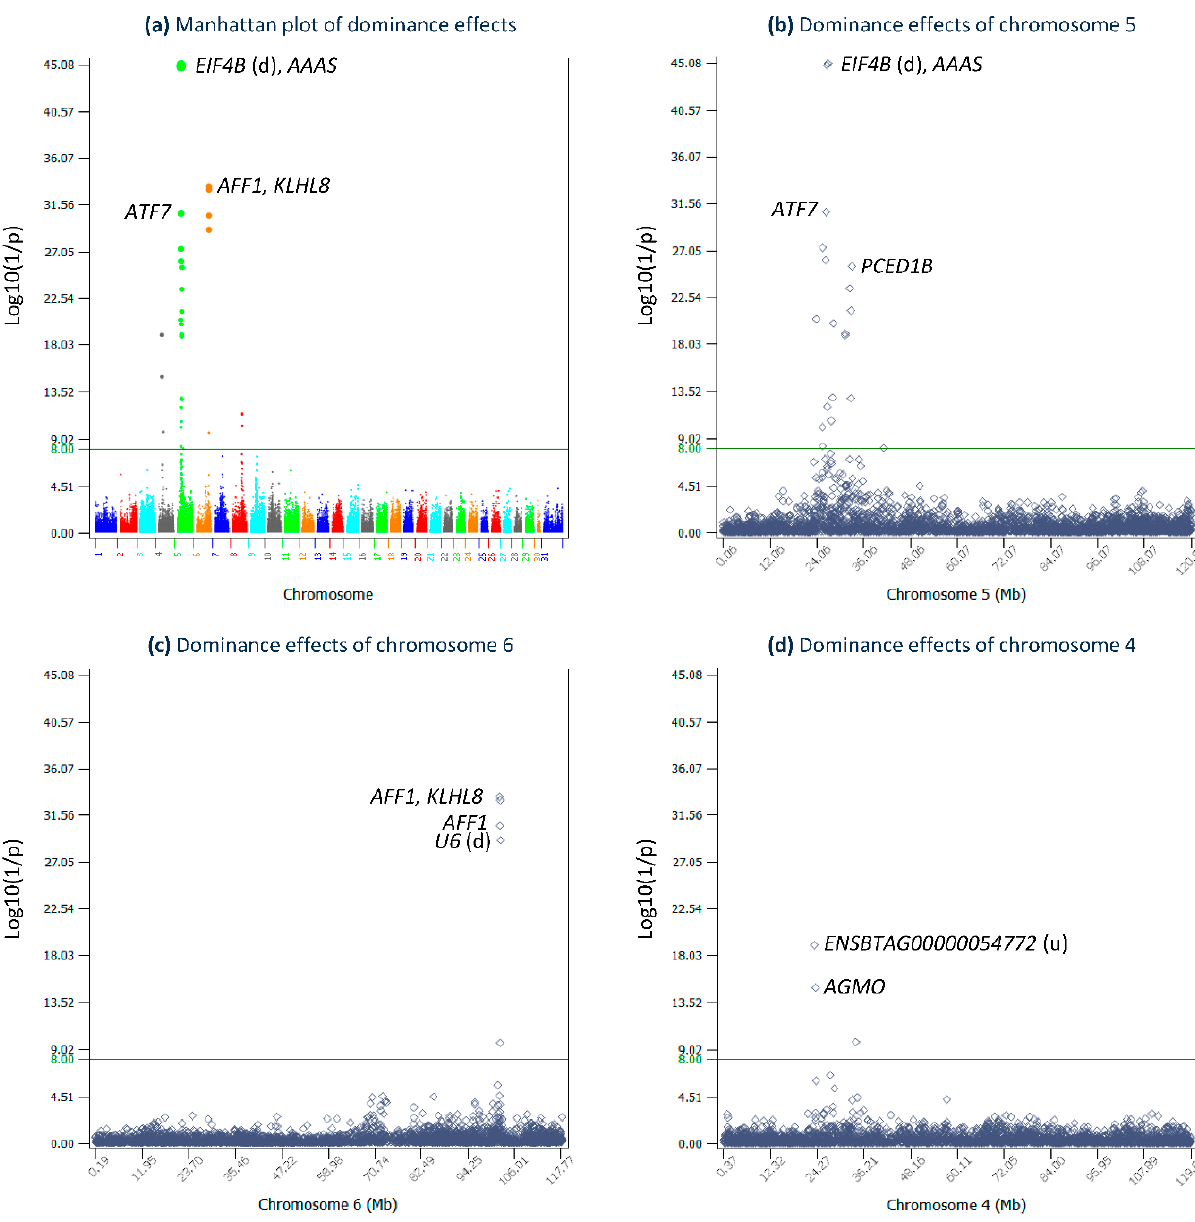
Figure 2. Graphical view of dominance effects. ( a ) Manhattan plot of dominance effects of all chromosomes. ( b ) Dominance effects of chromosome 5. ( c ) Dominance effects of chromosome 6. ( d ) Dominance e ff ects of chromosome 4. ‘u’ indicates the SNP is upstream of the gene, and ‘d’ indicates the SNP is downstream of the gene.